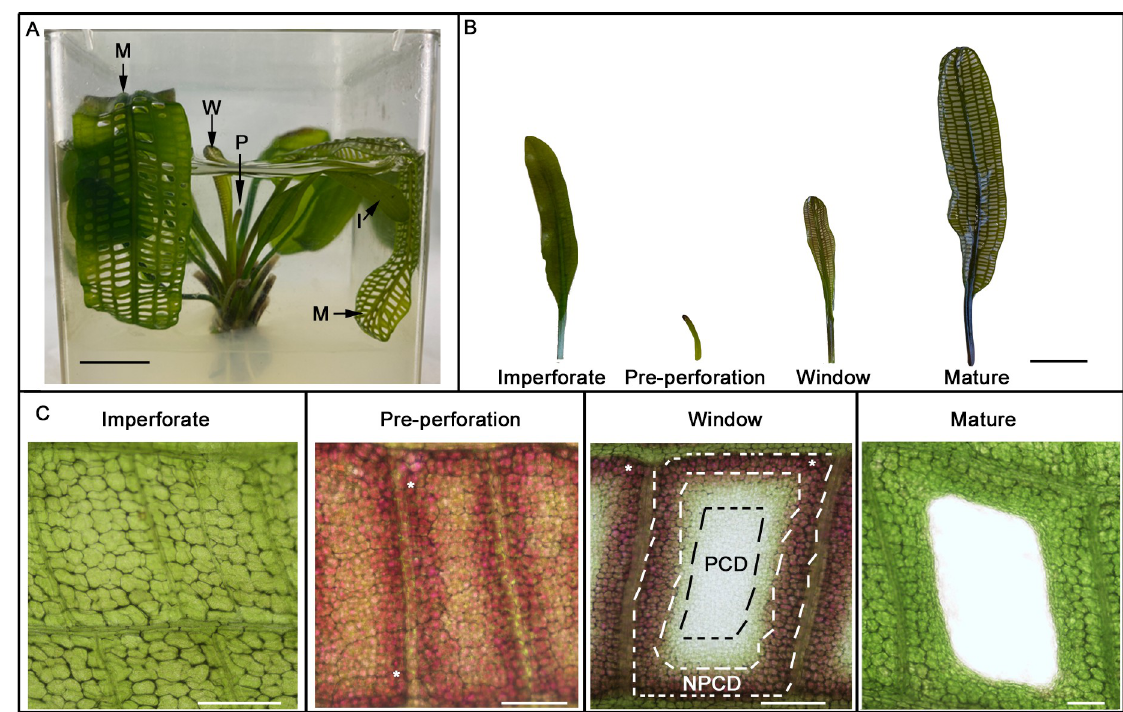
Fig 1. The lace plant programmed cell death (PCD) system. ( A ) Lace plants are grown in axenic Magenta box culture; pre-perforation stage (P), window stage (W), mature stage (M), and imperforate leaves (I). ( B ) Representative leaves at different stages of development. Imperforate leaves are the first 3–4 leaves to emerge from the corm and do not produce perforations. Pre-perforation stage leaves emerge from the corm with anthocyanin pigmentation. These eventually develop visible areolar “windows” that will eventually become perforated in mature leaves. ( C ) Details of PCD process. PCD does not take place in imperforate leaves. In pre-perforation leaves, anthocyanin pigmentation is visible, especially at the periphery of the areole ( asterisks ). PCD can be seen actively occurring in the window stage of development as a gradient of cell death. Non-PCD cells (NPCD, bounded by white dashed lines ) persist beyond maturity, early-PCD cells (EPCD, bounded by inner white dashed lines and black dashed lines ) have lost their anthocyanins and are destined to die, and late-PCD cells (LPCD, bounded by black dashed lines ) are nearly transparent and on the verge of death. Perforation formation is completed in mature stage leaves. Anthocyanin abundance is visibly reduced, and homeostasis for NPCD cells is reached. Scale bars : A = 1 cm, B = 2 cm, C = 70 μ